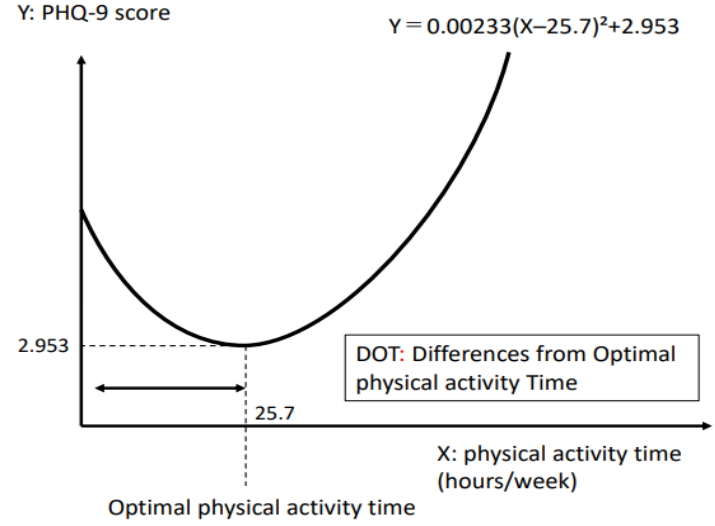
Figure 1. Correlation between PHQ-9 score and physical activity time.